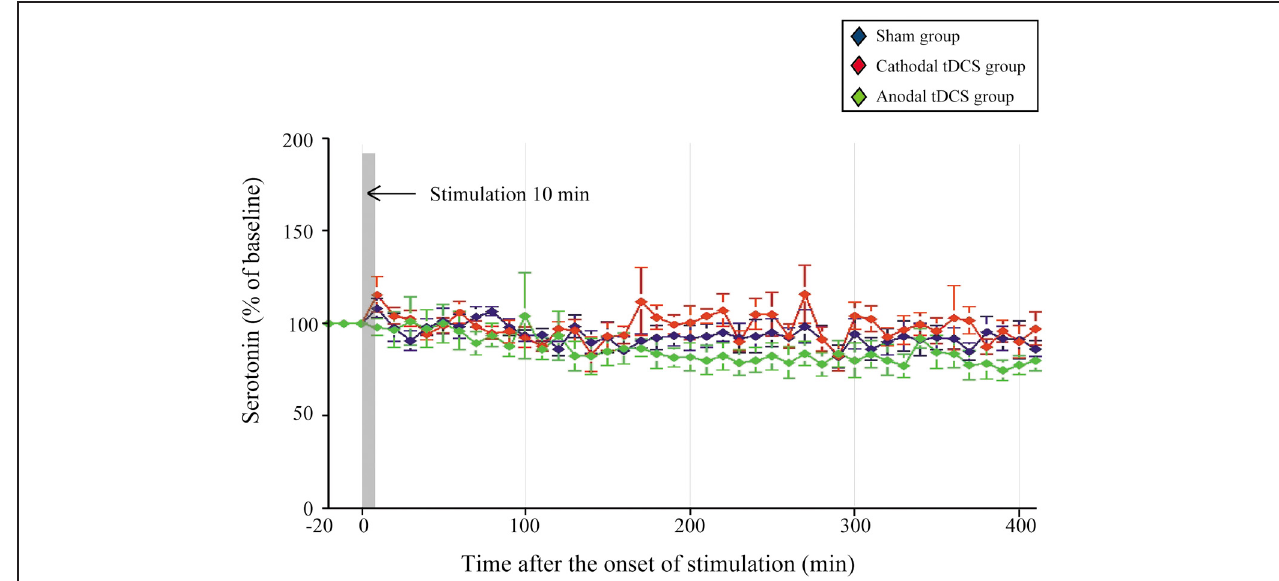
FIGURE 3 | EffectoftDCSonextracellular serotoninlevels inthestriatum. The absolute basal dialysis levels of serotonin in the striatum detected 10min before the interventions did not differ between groups. Serotonin levels were